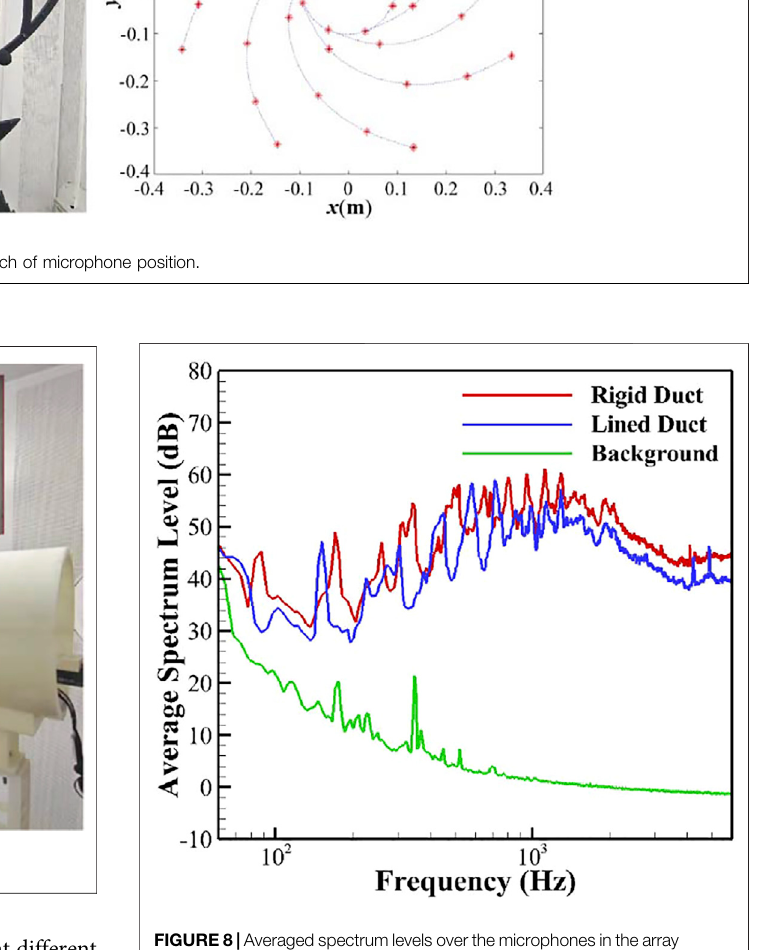
Figure 3 . The highest sound absorption coef fi cients of these subunits are all above 0.9. Therefore, broadband sound absorption can be well achieved by combining these four subunits into a meta-liner.